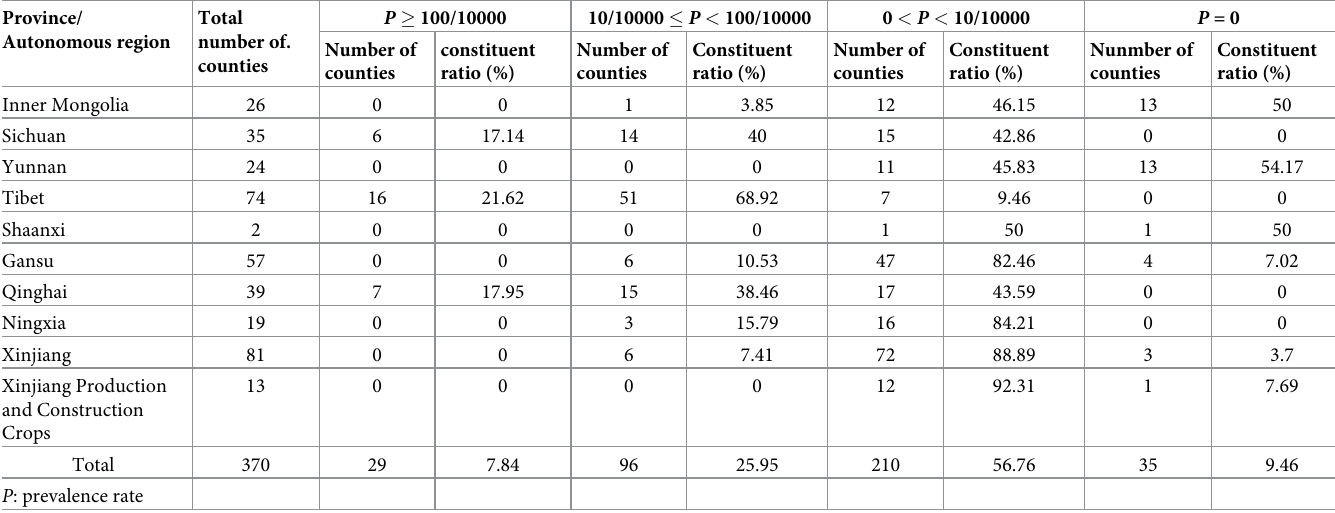
Table 2. Classification of the prevalence rate for human echinococcosis in China, 2018. Province/ Total Autonomous region number